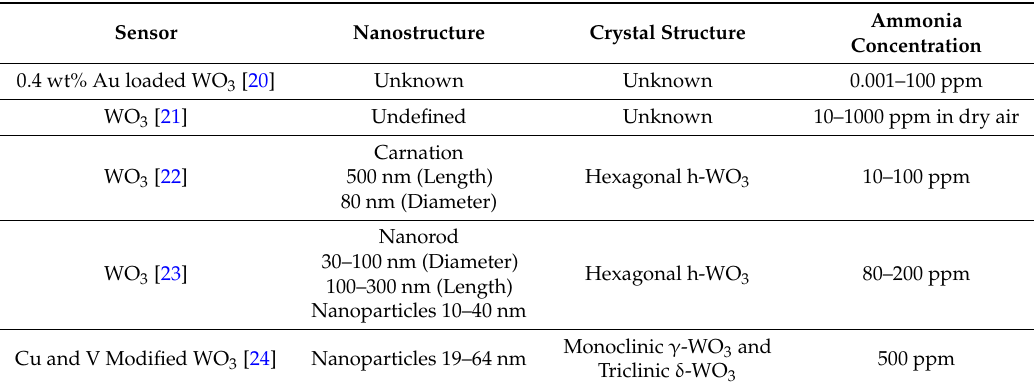
Table 6. A list of different samples used to detect